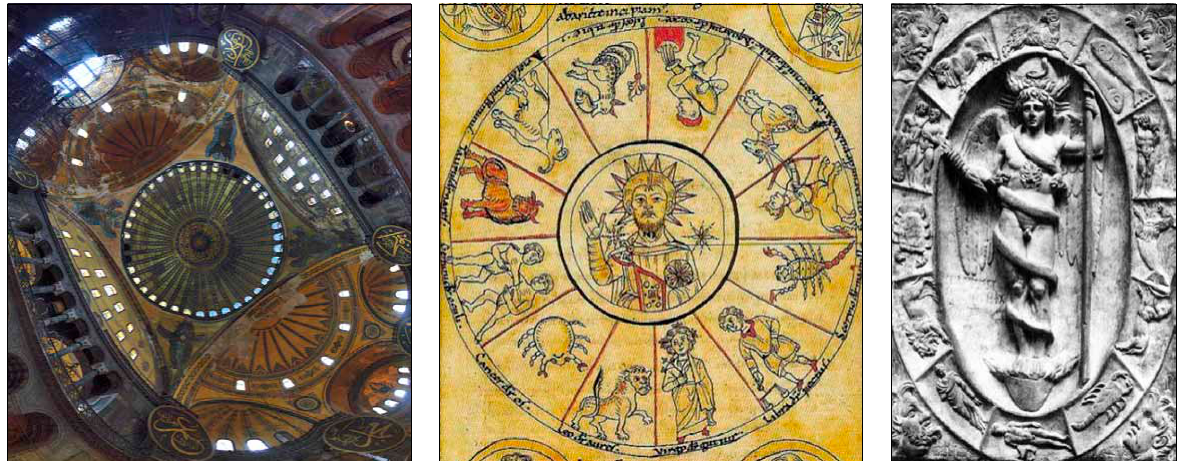
fig. 2. Symbolism of the dome of Hagia Sophia in comparison to the 8th century drawing of Christ the Sun and the 2nd century orphic medallion of primal god Phanes, which was found in the 15 th century rome. Sources : http://gabinetedehistoria.blogspot. com/2011_05_01_archive.html; http://www.nyhetsspeilet.no/2010/04/amanita-muscaria-den-hellige-gral/; http://en.wikipedia.org/ wiki/Hagia_Sophia.